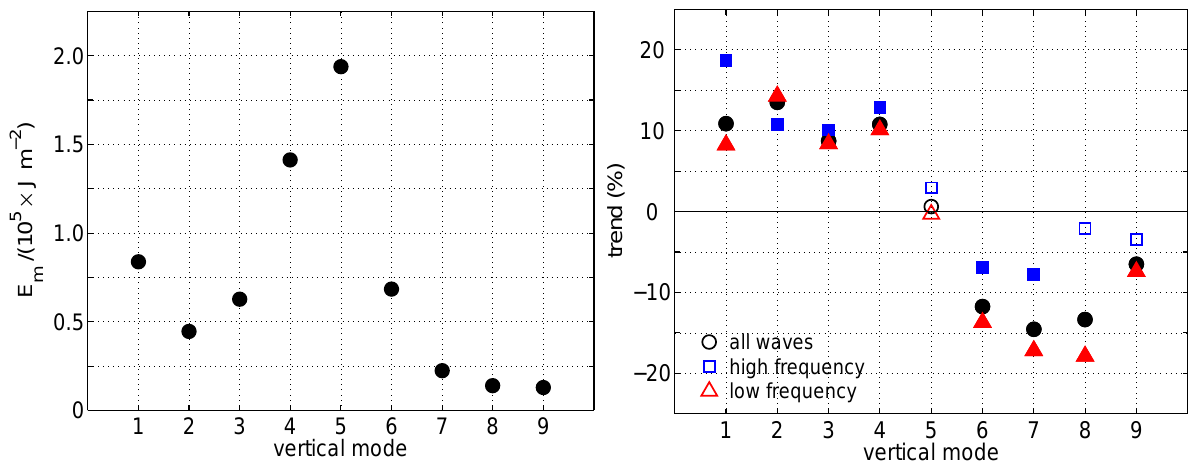
Fig. 3. Left: Vertical spectrum of the mean energy ( E m ) associated with the baroclinic Rossby waves of wave numbers s = 1 ,..., 10. Right: Linear trends of the November–April mean energy associated with the Rossby waves of wave numbers s = 1 ,..., 10, for the first 9 baroclinic modes. The trends are given as percentages of the respective mean energies in the period of 1958–2006. Solid symbols indicate significant trends at the statistical level of 99% ( p = 0 . 01).